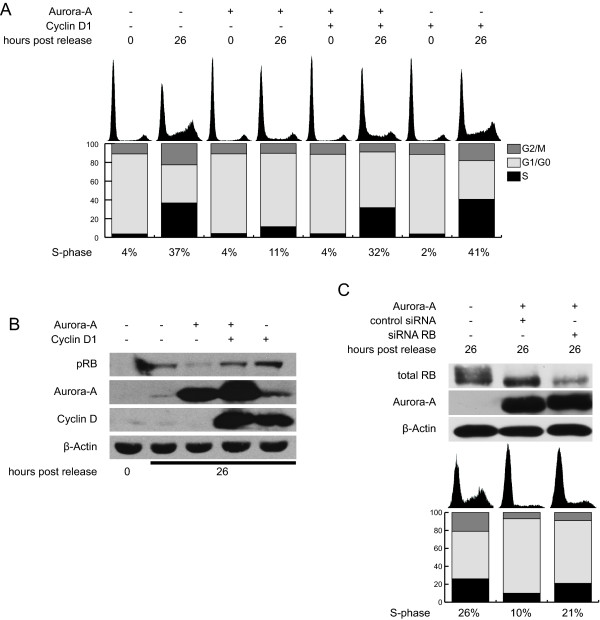
Influence of Cyclin D1 co-expression along with Aurora-A on G1/S arrest. G0 arrested Wi-38 cells were infected with the viruses expressing the indicated proteins 24 hours after serum depletion. 48 hours after infection, serum was added. (A) At the indicated time points, PI-stainings were performed. (B) In parallel, cell extracts were analyzed by immunoblotting with the indicated antibodies. A representative experiment of at least three experiments is shown. (C) Serum arrested cells expressing Aurora-A or lacZ were transfected with the control or Rb specific siRNA. 26 hours after serum release, cells were analyzed by immunoblotting and PI-stainings.